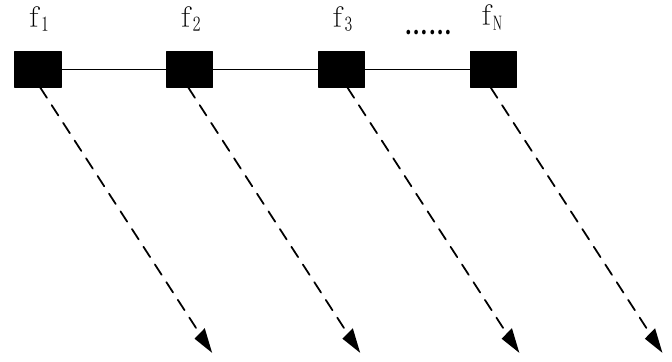
Figure 1. Illustration of frequency diverse array (FDA) with an identical frequency increment.